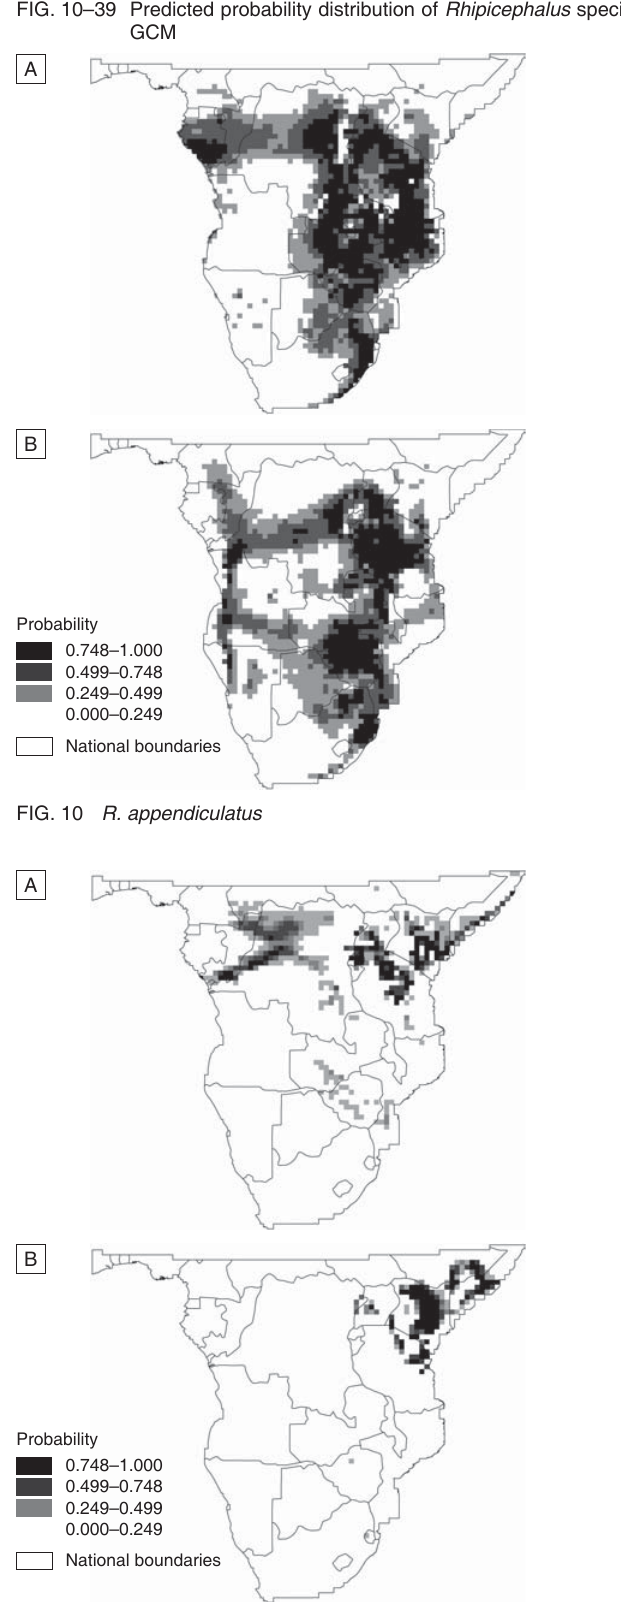
FIG. 12 R. armatus FIG. 13 R.